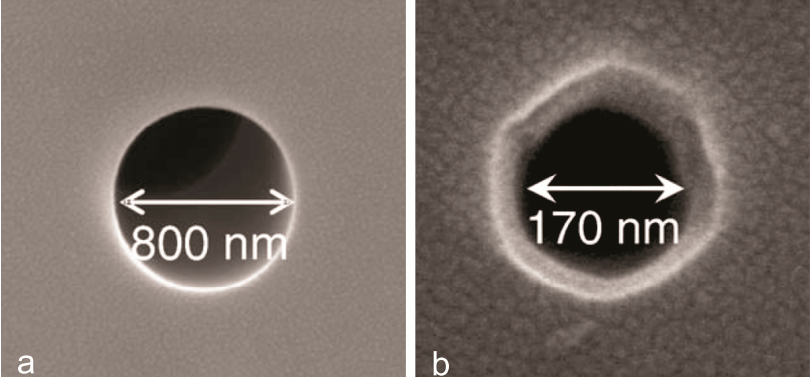
Figure 3. Formed pore from 90 nm silicon nanowire template etched with XeF 2 : ( a ) 200 cycles and ( b ) 50 cycles etching process [33], reproduced with permission. Copyright Elsevier